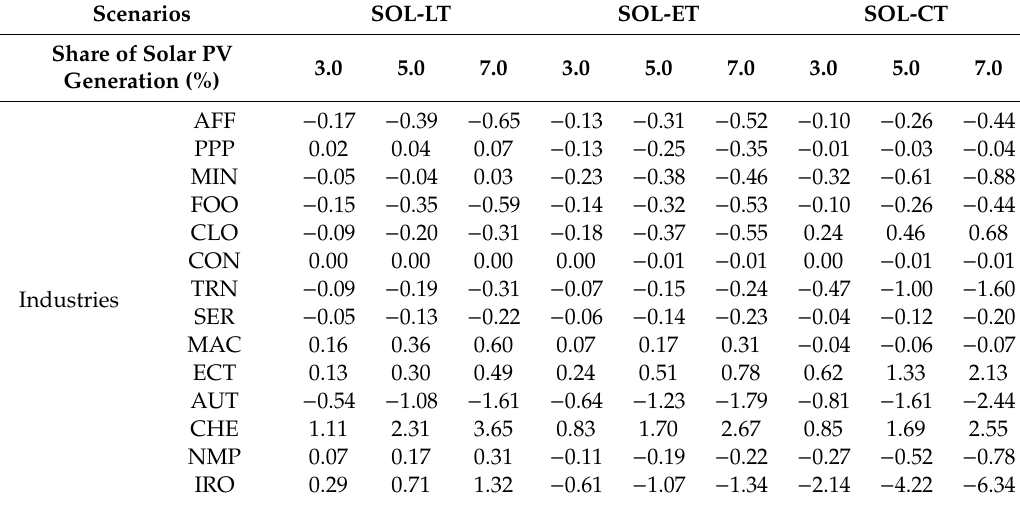
Table 8. Changes in output by industry according to the increase in the share of solar PV power generation (% changes in output from the base year).